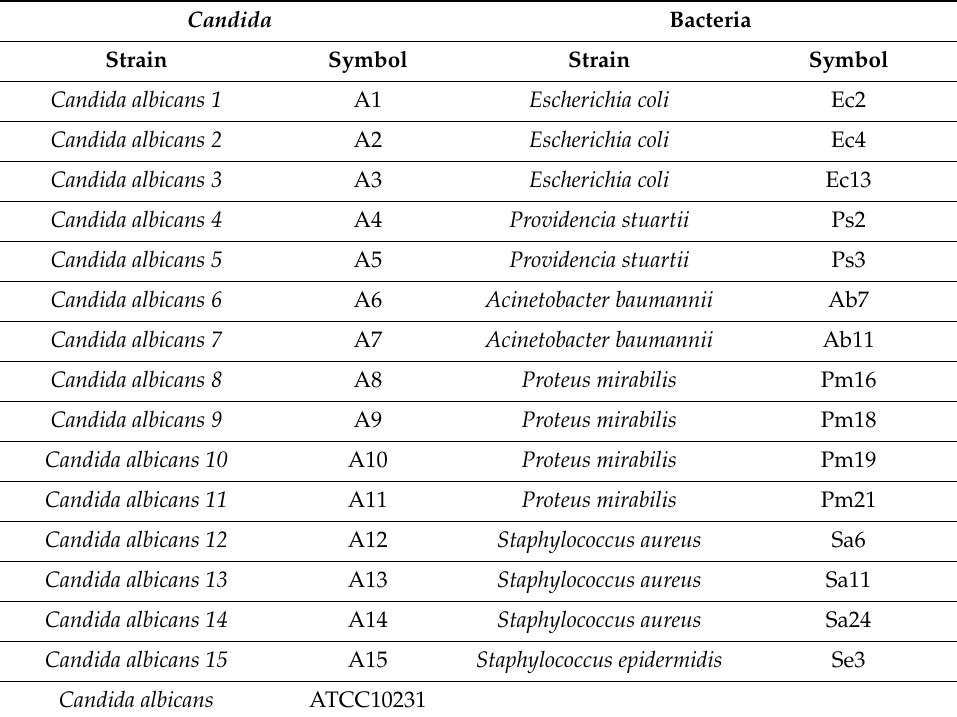
Table 1. Candida and bacterial strains employed in the